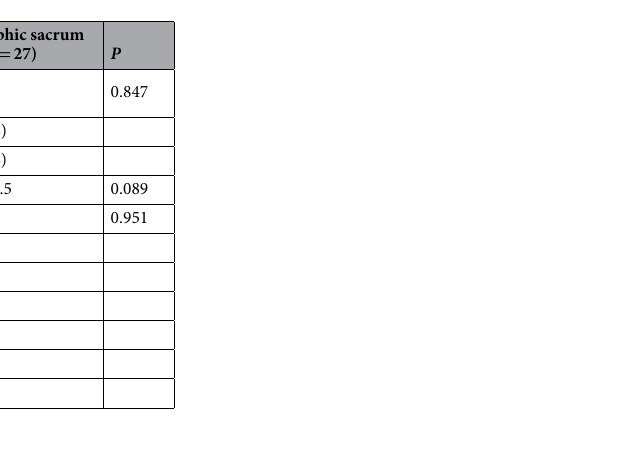
Table 1. Demographic